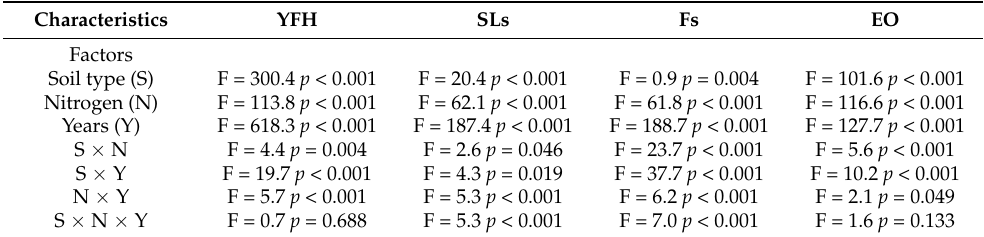
Table 2. Main effects of the experimental factors on the yield of flower heads (YFH) and the content of sesquiterpene lactones (SLs), flavonoids (Fs), and essential oils (EO) in the flower heads of A. chamissonis .